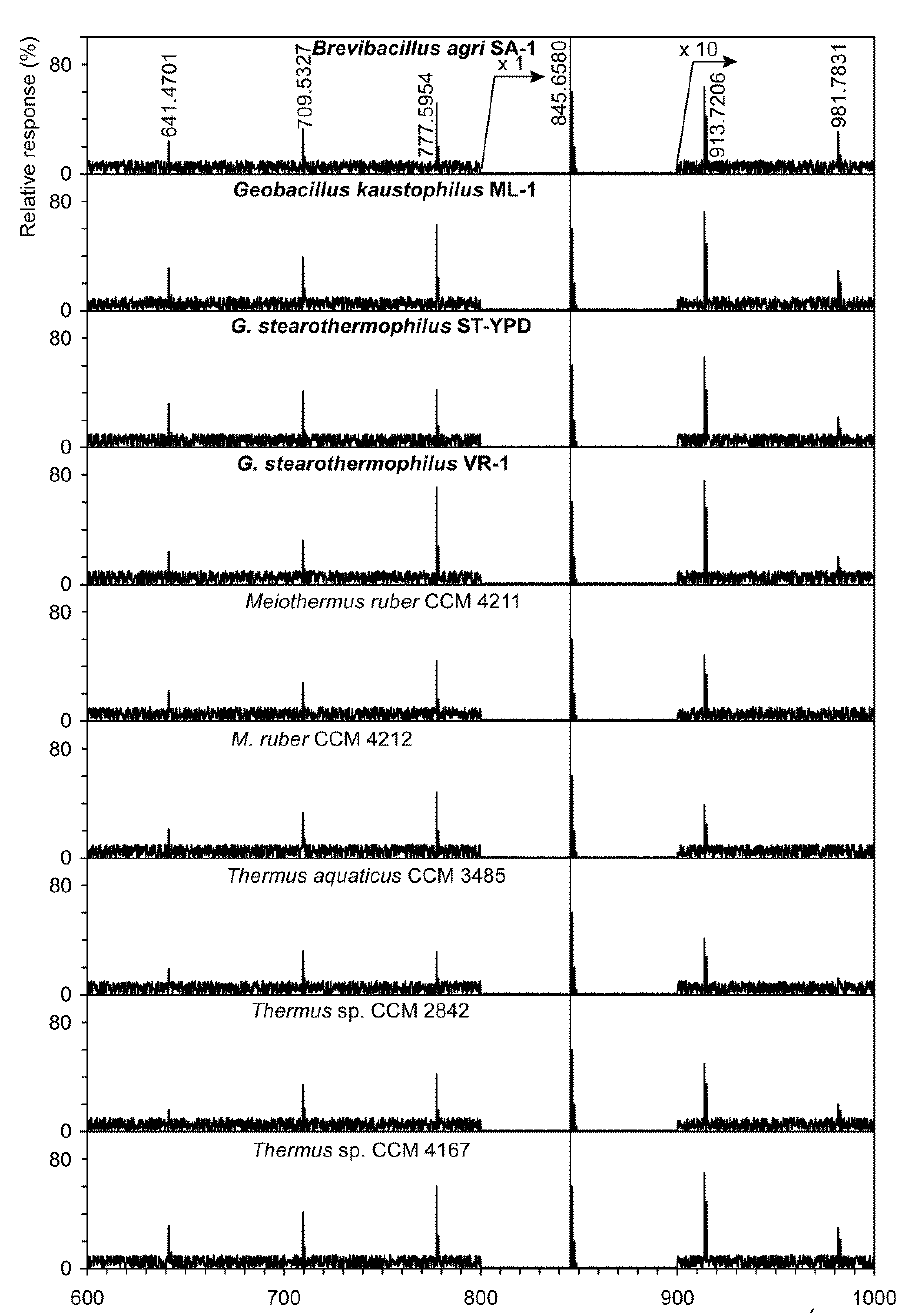
Figure 1. Shotgun analysis of a mixture of polyprenol phosphates from thermophilic bacteria obtained from the Czech Collection of Microorganisms (Brno, Czech Republic) and isolated from hot springs (marked in bold). Precursor ion scan at m/z 163.0165, see structure formula at the top right.